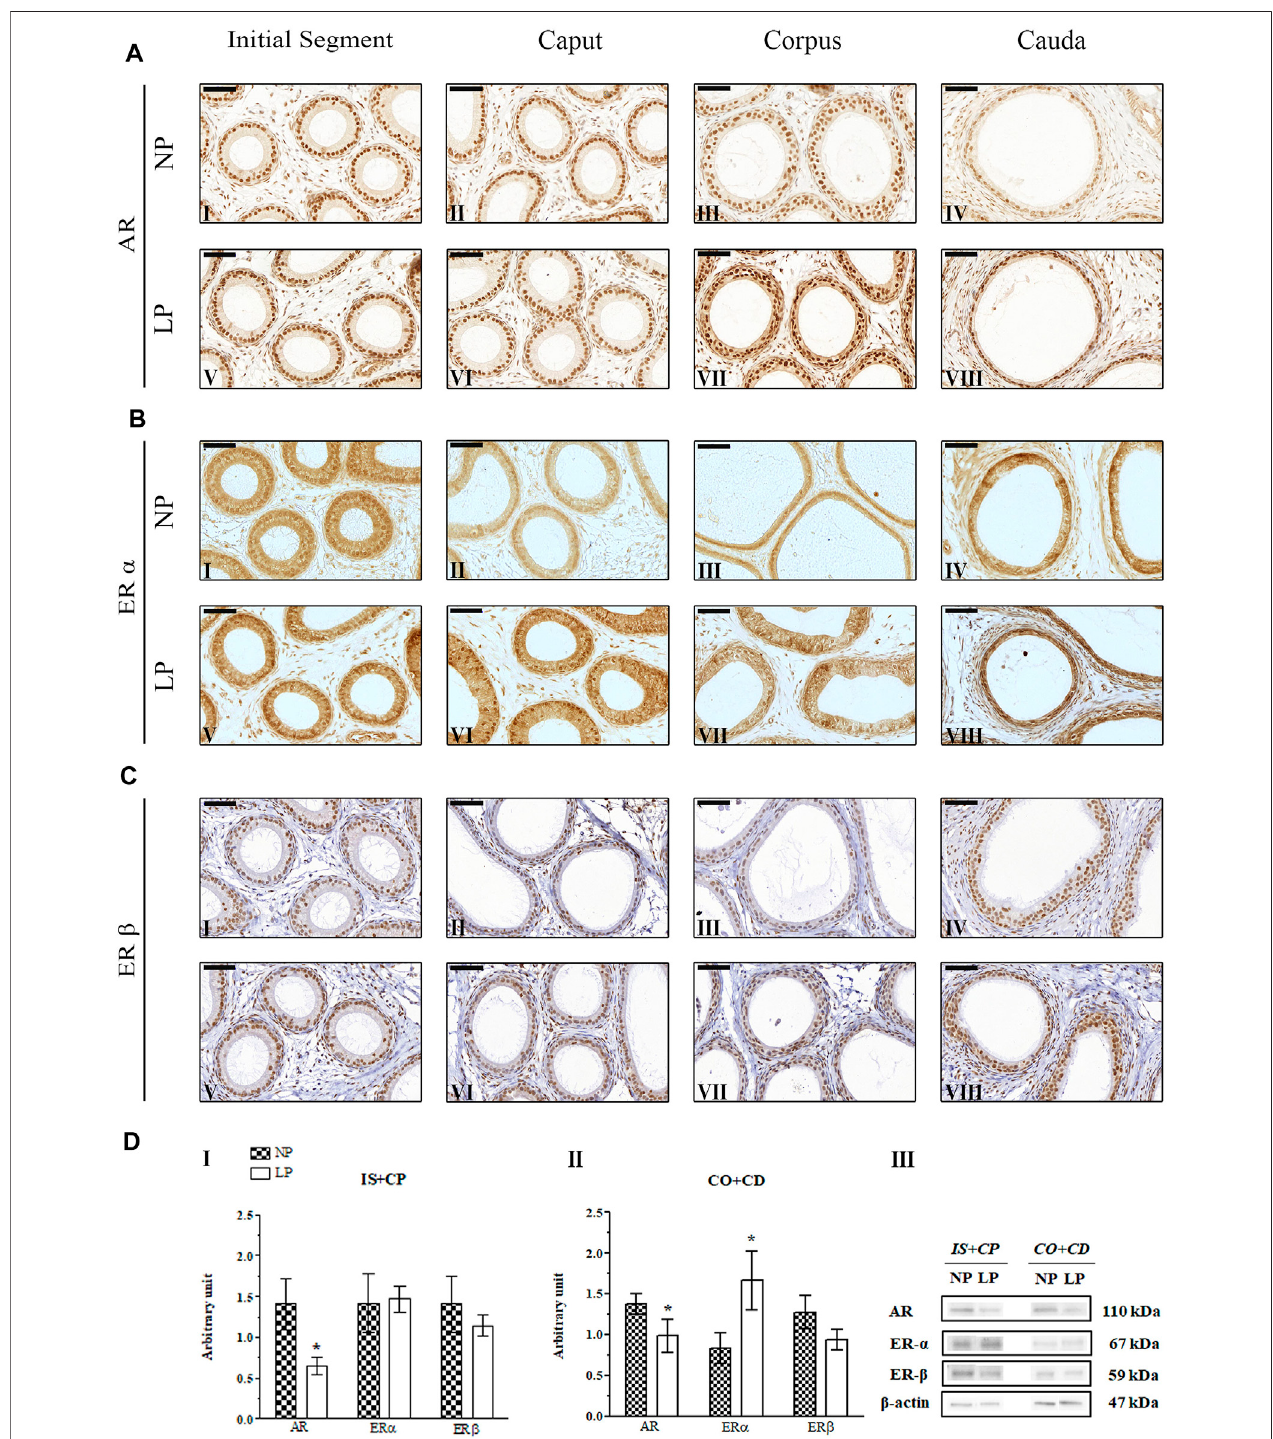
FIGURE5| ExpressionandimmunolocalizationofAR,ER α andER β intheepididymidesof44-day-oldanimals .(A) ImmunoreactivityforARinepithelialcellsandin mesenchymal cells in the initial segment (I and V) , caput (II and VI) , corpus (III and VII) and cauda (IV and VIII) regions of NP and LP animals. (B) Immunoreactivity for ER α in epithelial cells and in mesenchymal cells in the initial segment (I and V) , caput (II and VI) , corpus (III and VII) and cauda (IV and VIII) regions of NP and LP animals. (C) ImmunoreactivityforER β inepithelialcellsandinmesenchymalcellsintheinitialsegment (IandV) ,caput (IIandVI) ,corpus (IIIandVII) andcauda (IV andVIII) regionsofNPandLPanimals.Bar=50 µm. (D) Extractsobtainedfromindividualanimalswereusedfordensitometricanalysisofthelevelsoftheproteinsinthe initial segment plus caput (I) and corpus plus cauda (II) regions following normalization to the levels of the housekeeping protein β -actin. The representative blots show the protein levels of AR, ER α , ER β and β -actin ( III , right panel). The data are presented as the mean ± S.E.M. * p < 0.05, Mann-Whitney test.